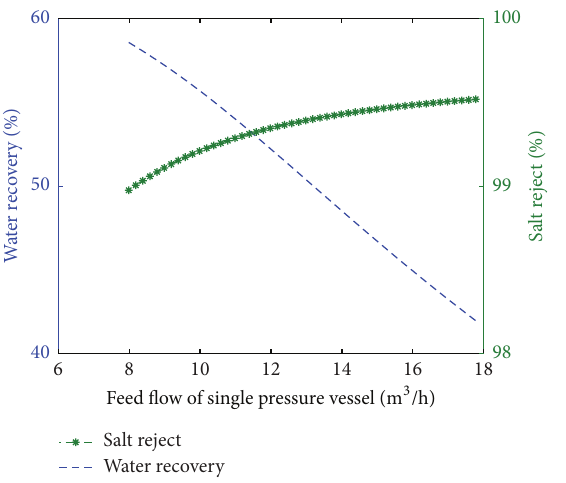
Figure 15: Rec and Ry as the function feed temperature.